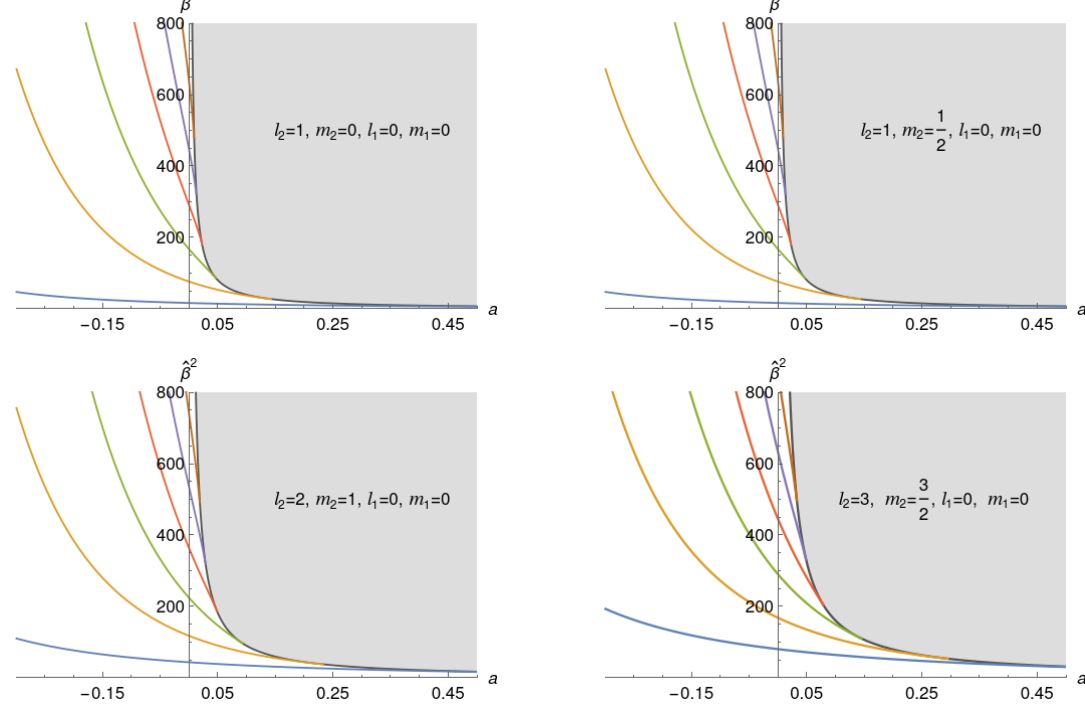
ˆ β 2 of equation (5.49) with and m R (as labelled). Parameter a is 2 2